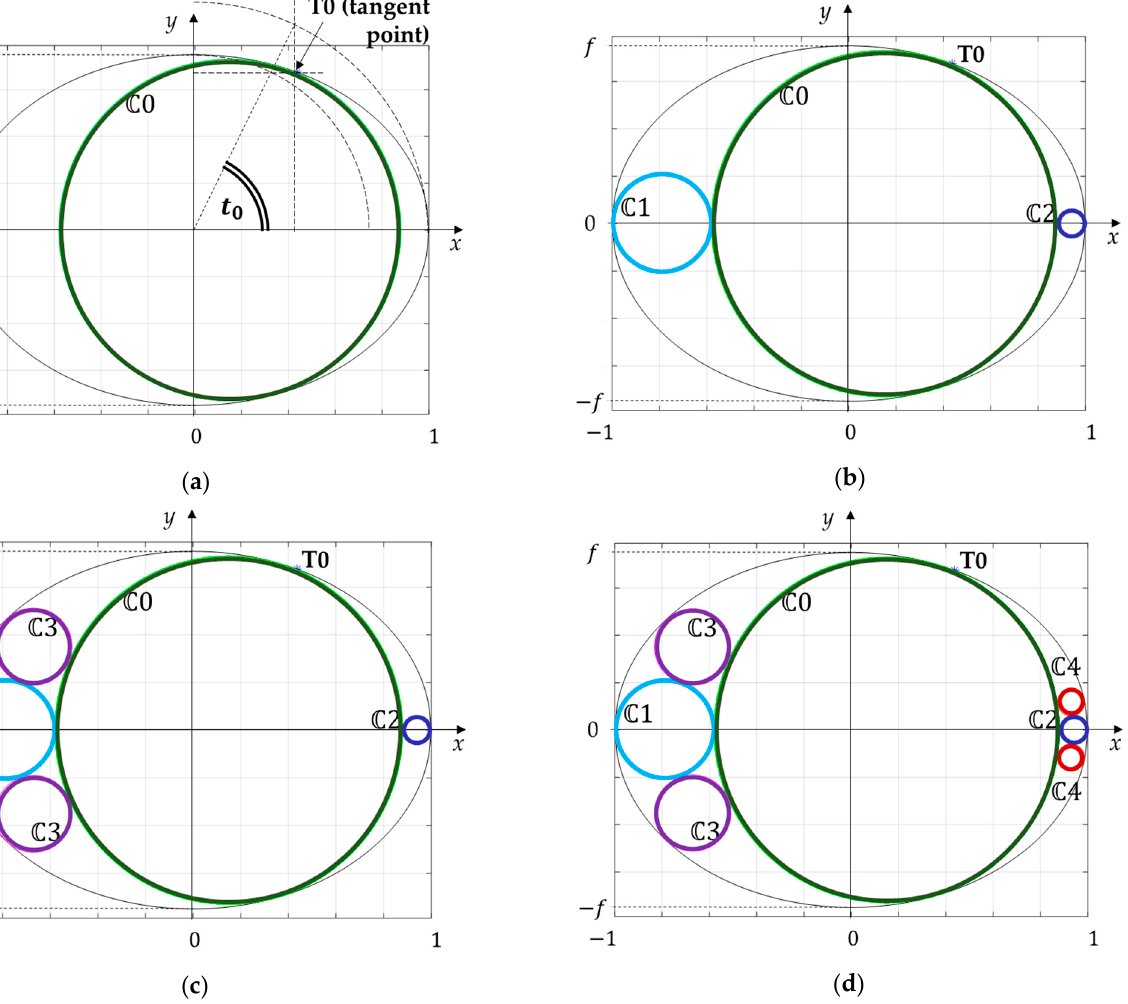
Figure 8. Full-section layout: steps for definition of the space available for the tanks within the fuselage cross-section: ( a ) definition of the main tank cross-section, ( b ) introduction of mid-size side tanks, ( c ) introduction of an additional couple of tanks on the left-side, ( d ) introduction of an additional couple of tanks on the right-side